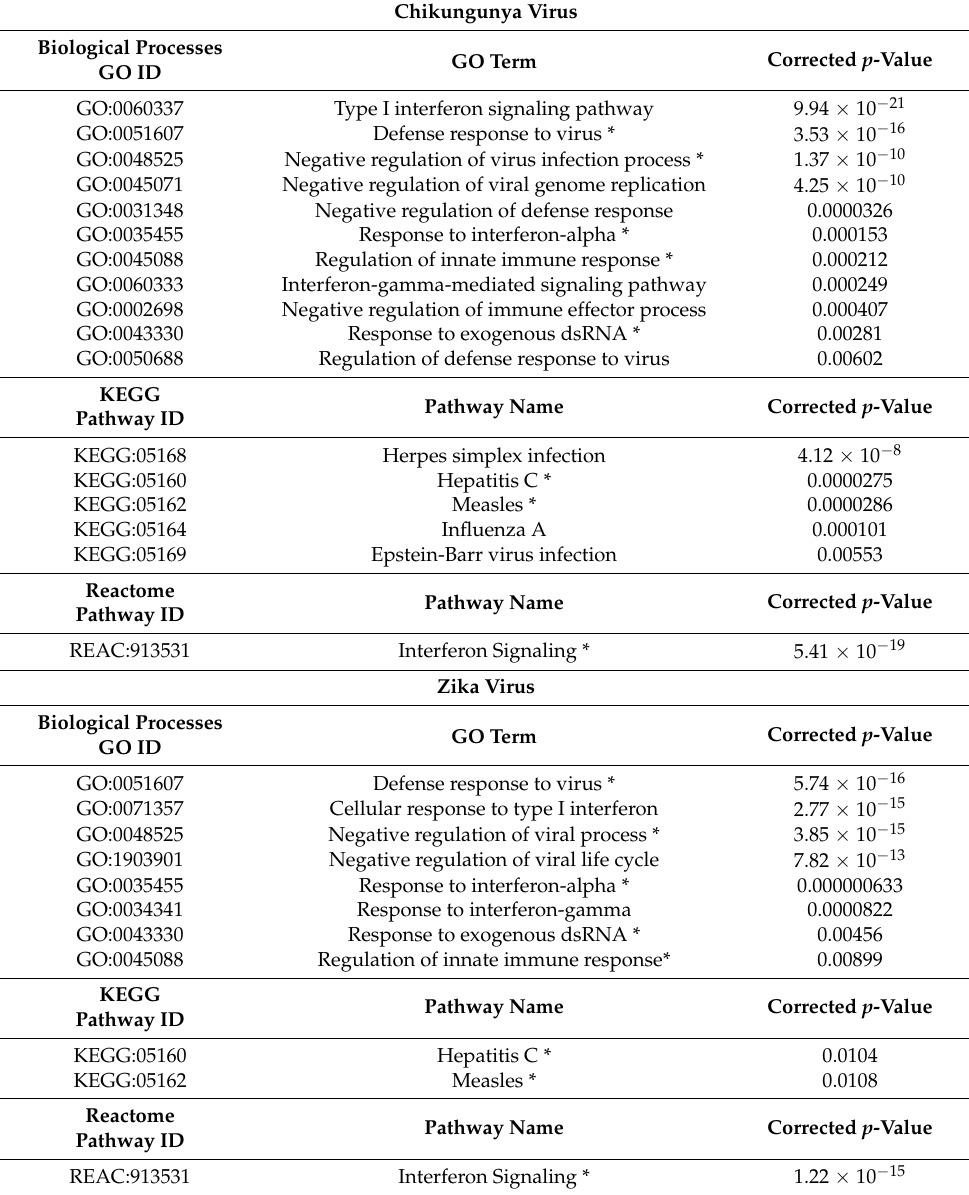
Table 2. Functional annotations: Significant pathways identified from CHIKV- and ZIKV-infected